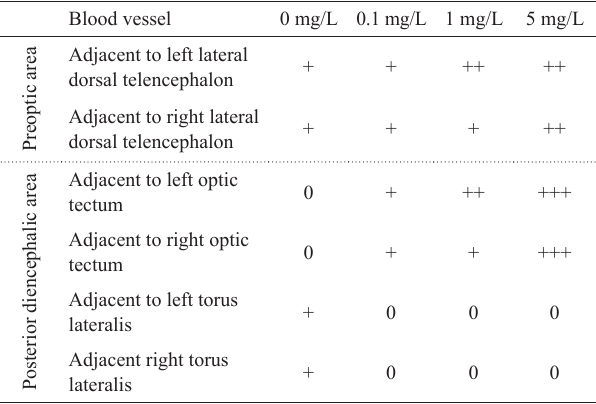
Tab. 2 . Qualitative assessment of MC abundance in adjacent blood vessel at Preoptic and posterior diencephalic (including hypothalamus) areas of Paracheirodon axelrodi. 0: Absence of MCs, 1 to 10 cells (+), 11 to 40 cells (++), more than 40 cells